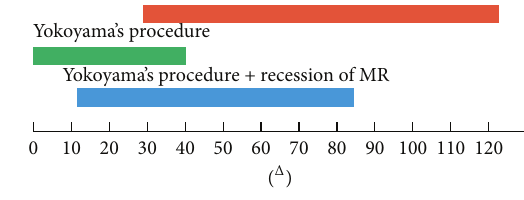
Figure 1: Applicable scopes of different surgical procedures for the treatment of high myopic strabismus. Yokoyama’s procedure alone can correct up to 40 Δ of esotropia. A combination of Yokoyama’s procedure and recession of the MR muscle is effective in patients with 12 to 85 Δ of esotropia. The partial Jensen’s procedure combined withrecessionoftheMRmuscleisabletocorrectesotropiaover 30 Δ